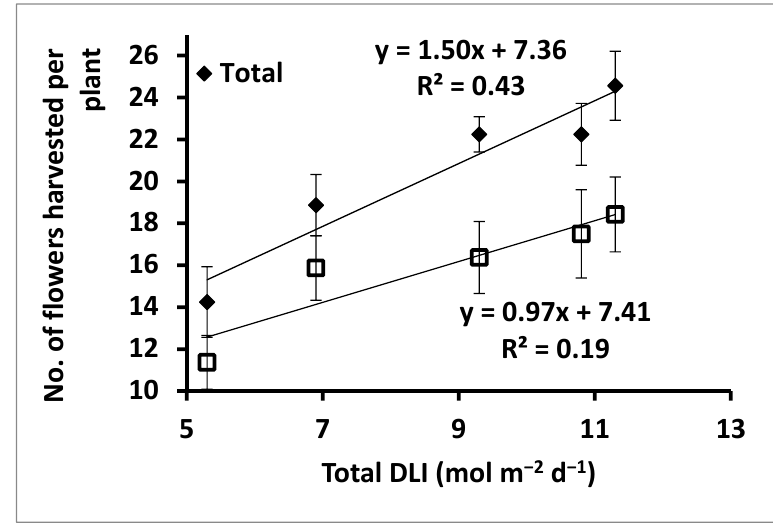
Figure 2. Cumulative total and marketable flowers harvested per plant, for ‘Panama’, in response to total daily light integral (DLI). Each point represents the treatment mean ± SE (n = 8); however, the equations are linear regressions of all of the harvest data on a per ‐ plant basis.